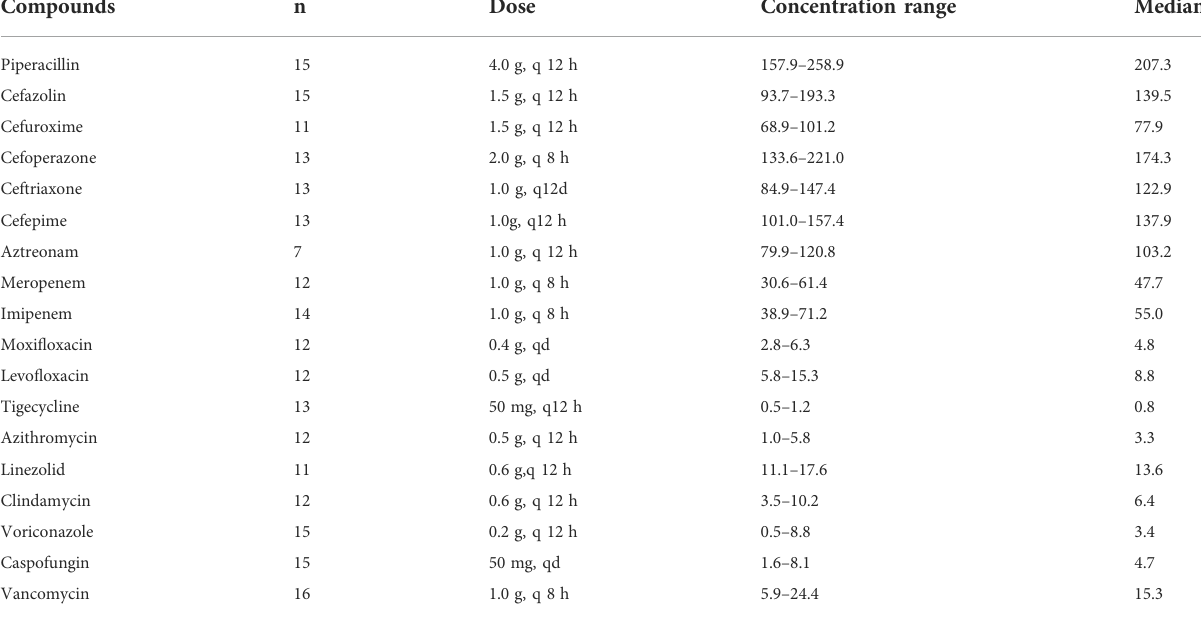
TABLE 7 Antimicrobial concentration ranges in 231 patient samples. (µg · mL − 1 ).